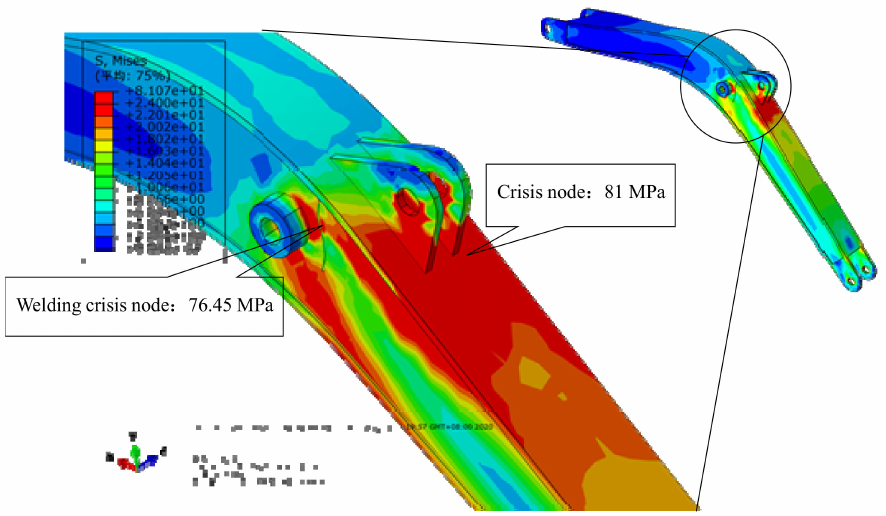
Figure 16. The stress contour of the remanufactured excavator